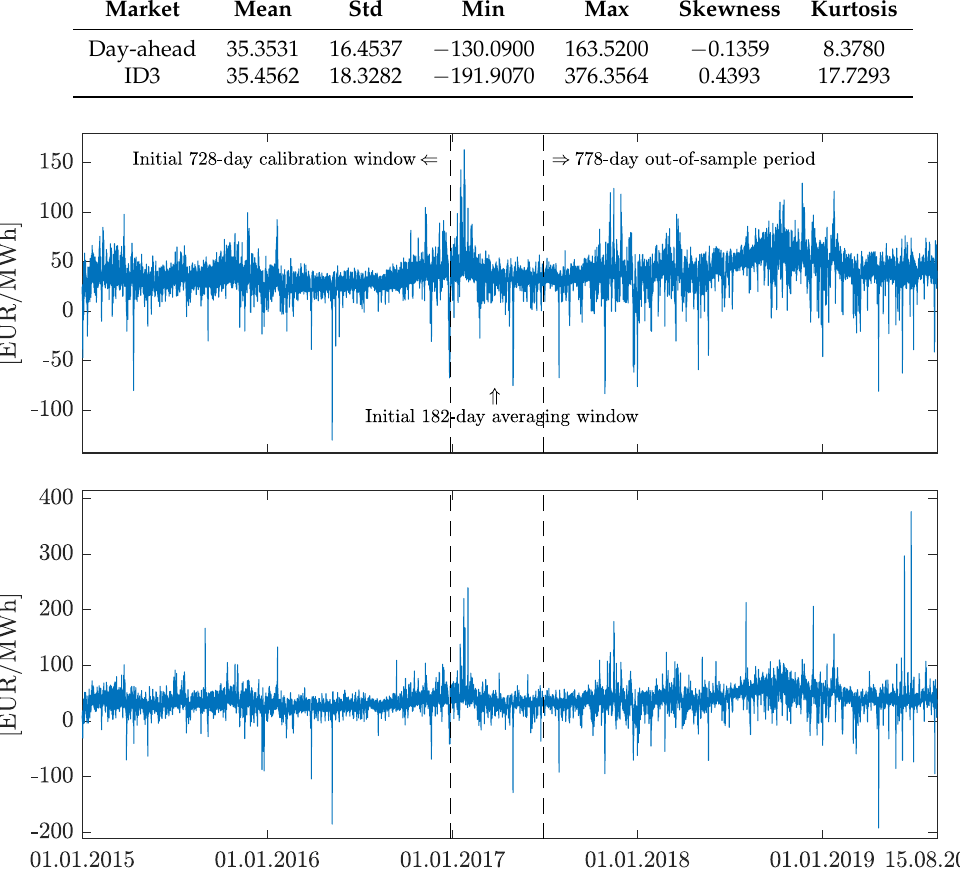
Figure 1. Day-ahead ( top ) and intraday (ID3) ( bottom ) hourly electricity prices for German market, from 1 January 2015 to 15 August 2019. The first vertical dashed line marks the end of the 728-day calibration period and the second marks the end of the initial 182-day calibration window for averaging